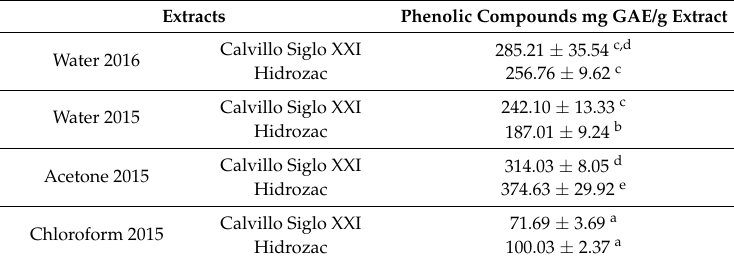
Table 1. Total polyphenols in the aqueous, acetone, and chloroform extracts of Calvillo Siglo XXI and Hidrozac leaves. The average values ( ± SD) are expressed as milligrams equivalent of gallic acid per gram of extract (mg GAE/g).